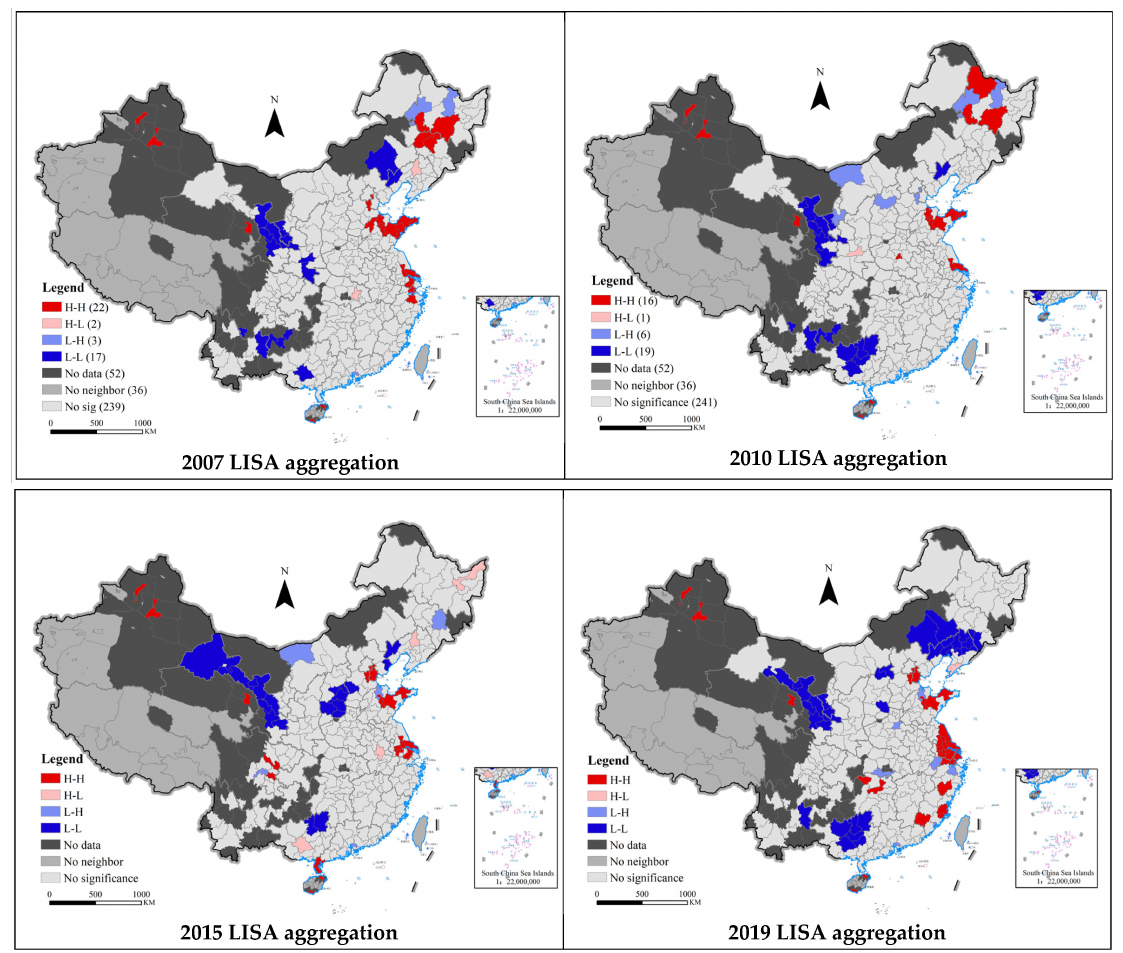
Figure 4. LISA cluster of ecological efficiency. Note: this map is based on the standard map with the drawing review number of GS (2020) 4619 on the standard map service website of the Ministry of Natural Resources. There is no modification to the base map. Table 3. Descriptive statistical